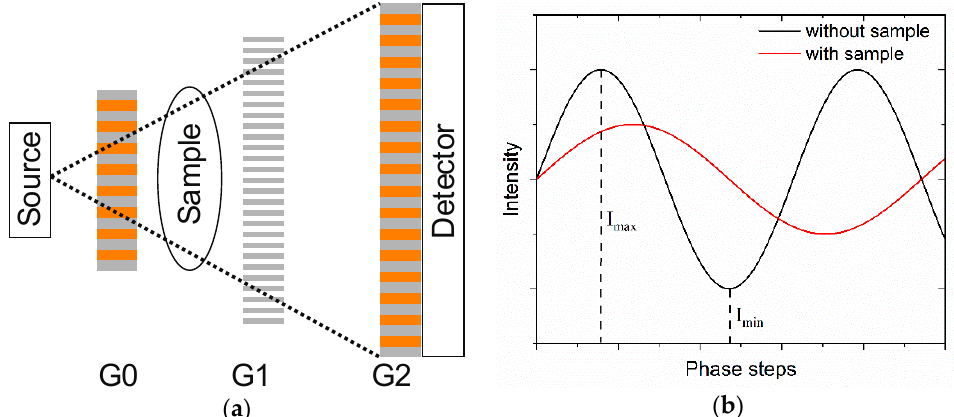
Figure 11. ( a ) Sketch of an X-ray grating interferometer in the Talbot–Lau configuration. ( b ) Scheme of the phase stepping